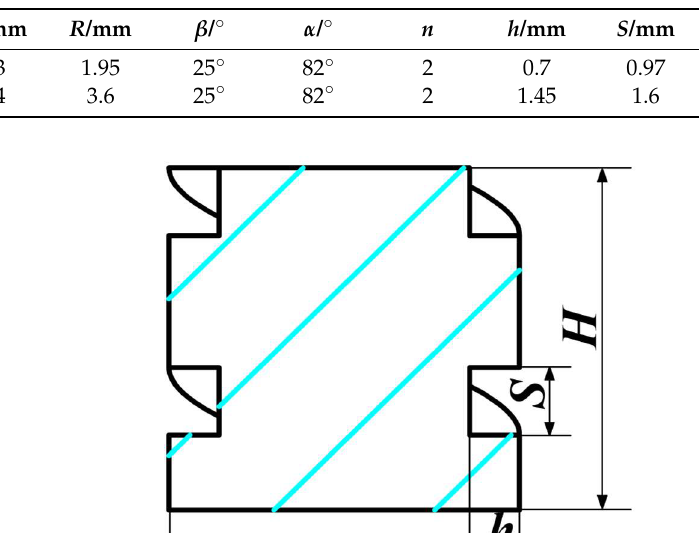
Table 2. Injector structure parameters.